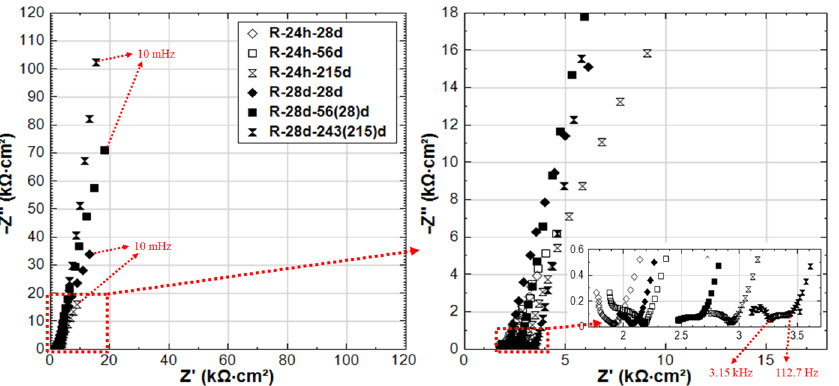
Figure 7. Electrochemical Impedance Spectroscopy (EIS) responses overlay in Nyquist format of R- 24h and R-28d (R-24h: Reference, 24h-cured specimen treated in water; R-28d: Reference, 28d-cured specimen treated in water).